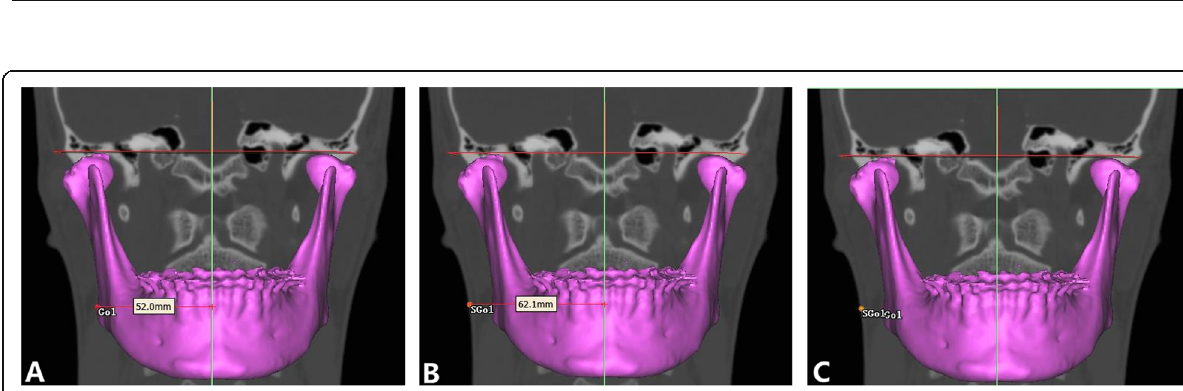
Fig. 2 Hard and soft tissue distance and soft tissue thickness were measured by establishing the horizontal line from the midsagittal reference plane to reference points on hard and soft tissue surfaces. A Hard tissue distance (Hard-D); B soft tissue distance (Soft-D); C soft tissue thickness